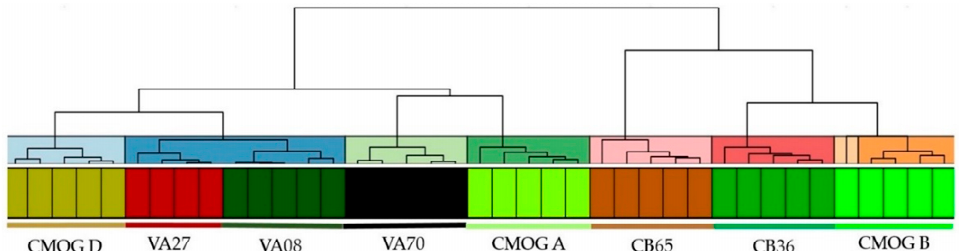
Figure 8. Hierarchical clustering plot that includes five datasets of each reference material (one for each XRF unit, except for VA27, which does not have values for Unisantis). The dendrogram features eight clusters distinguished by a different color (upper part). The bottom part shows color-coded datasets (each color represents a specific sample).